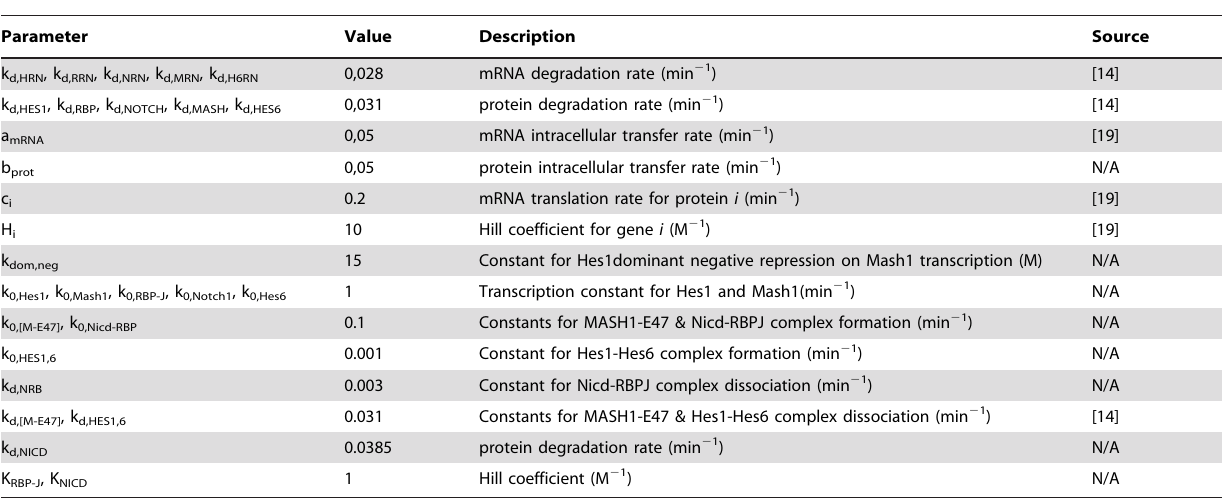
Table 1. Initial Parameter values.